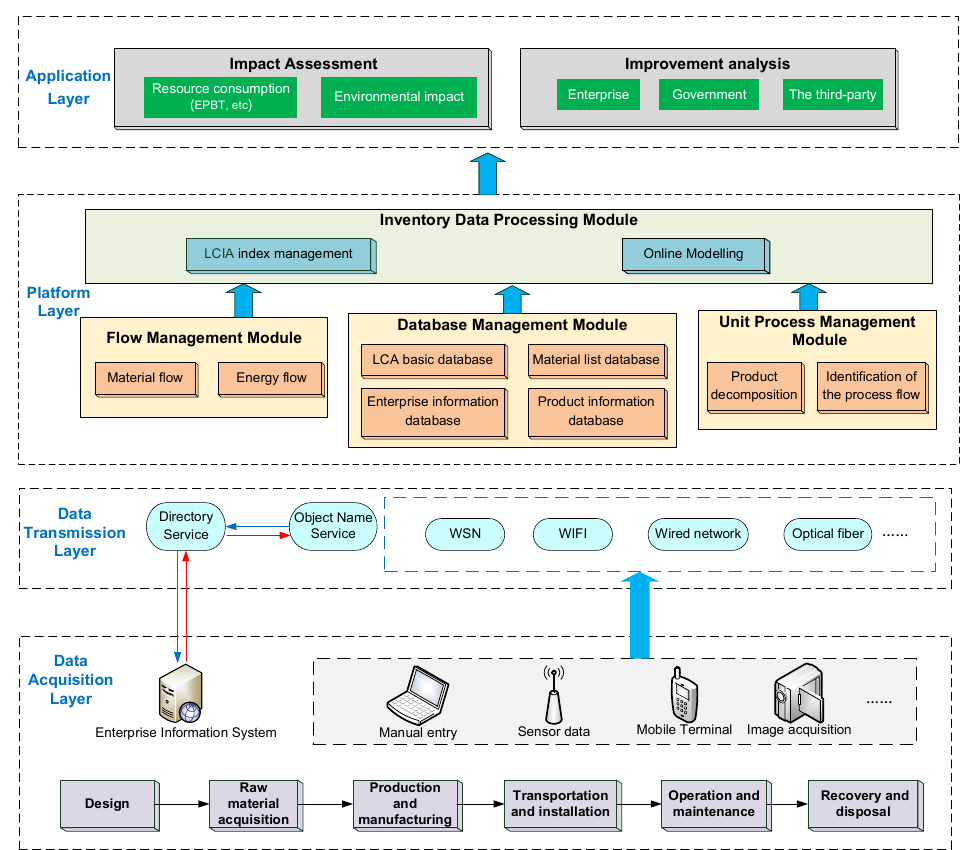
Figure 3. The architecture of IoT-based LCA platform of wind turbines. Each layer of the platform is introduced as